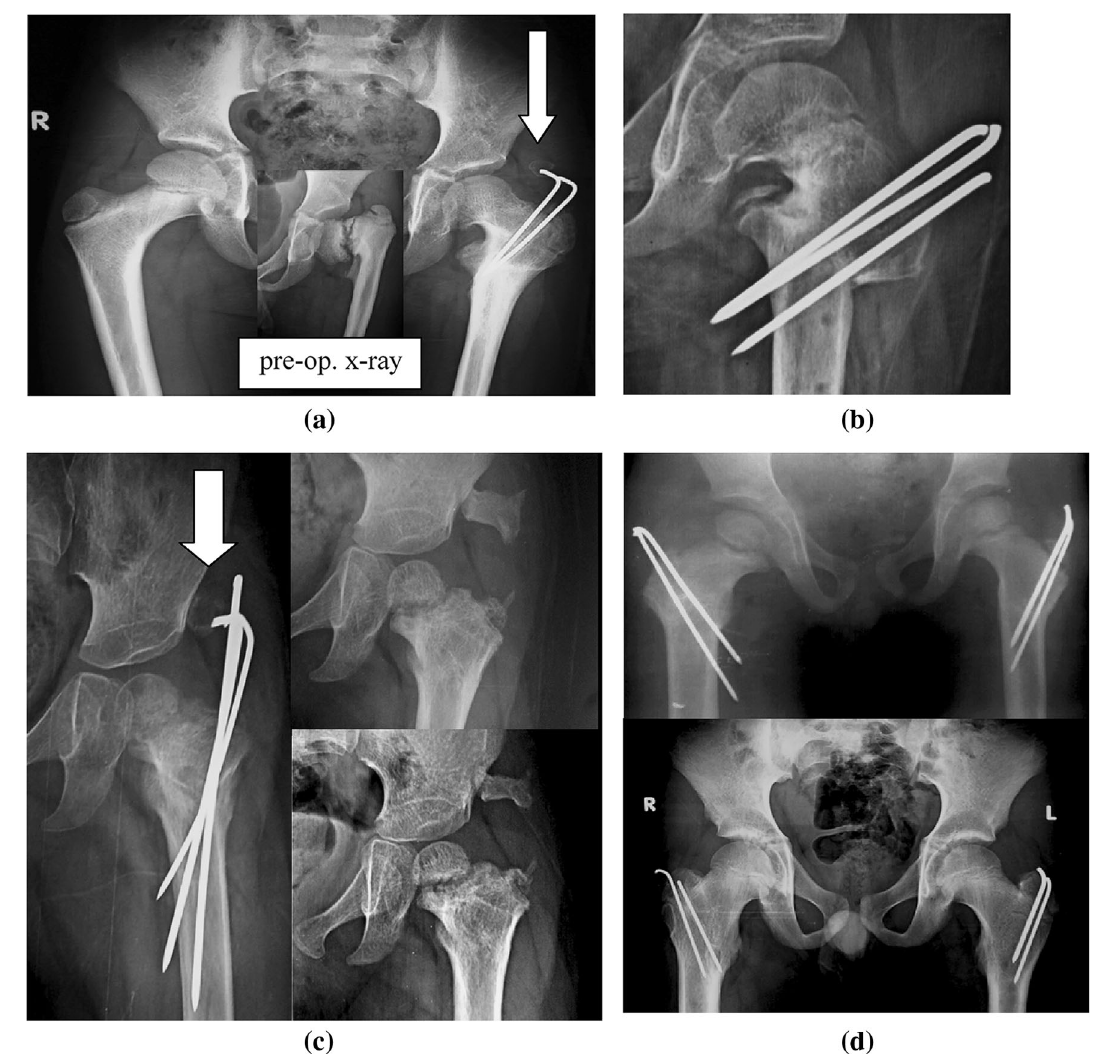
Fig. 8 Radiological findings for some of the cases studied. a Prema- ture proximal physeal closure and medial displacement of the distal fragment after osteotomy. The white arrow points to a hazy bony shadow associated with the ends of the wires in the gluteal region. b Marked medial displacement of the distal fragment after osteotomy in a revision case after a previous osteotomy fixed with plate and